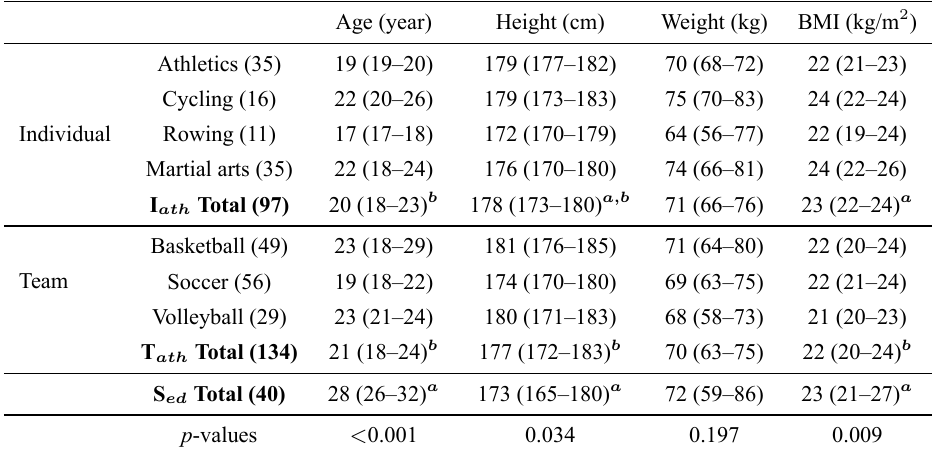
Table 2. Participants’ physical characteristics according to sport branches (Median-IQR) (n =